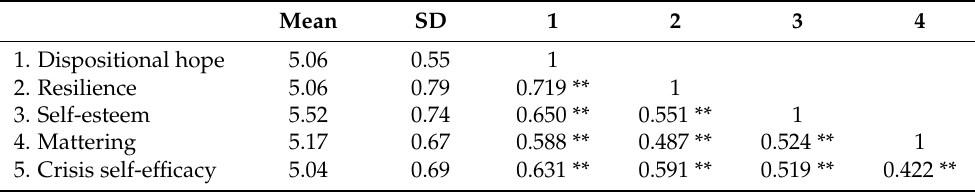
Table 1. Mean, standard deviation, and inter-correlation among